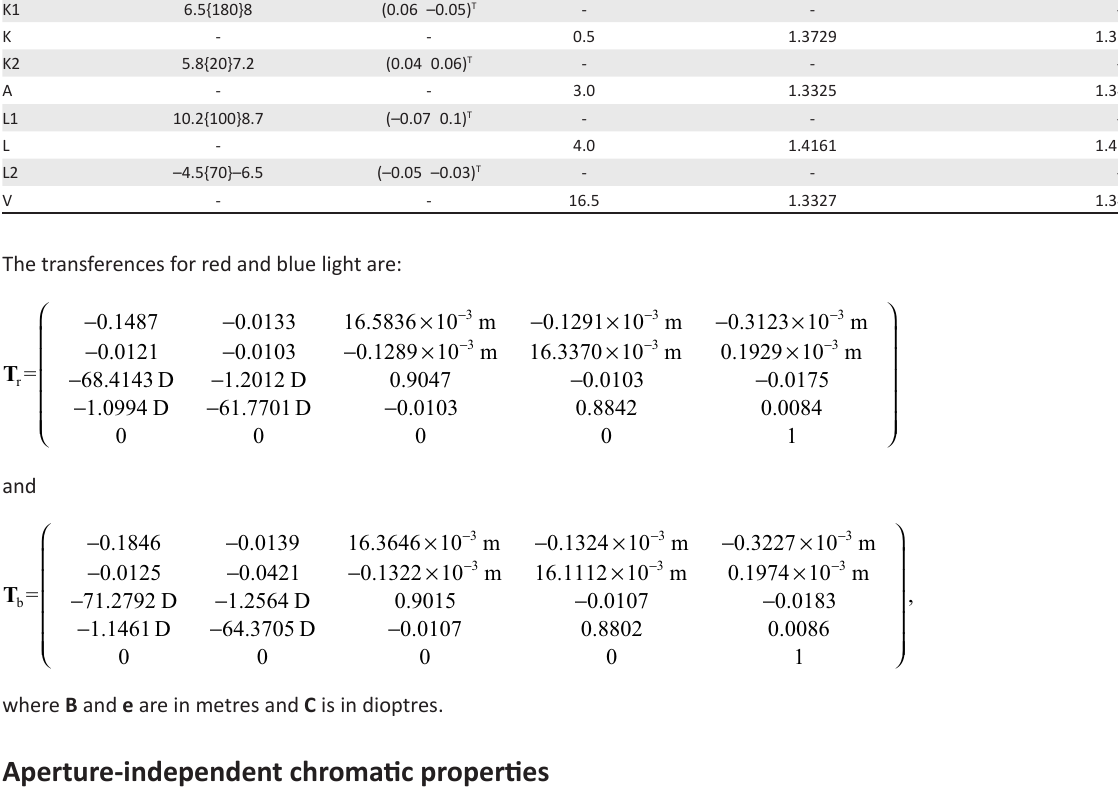
TABLE 1-A1: Principal radii of curvature and tilts of the four surfaces and separations and refractive indices of the four media of the arbitrary astigmatic heterocentric eye used in the numerical example.